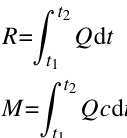
in different runoff components for the rainfall-runoff events (The asterisk represents an